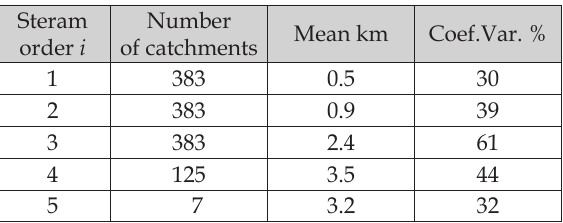
Table 2. Average length of the i order stream Steram Number Mean order i of catchments